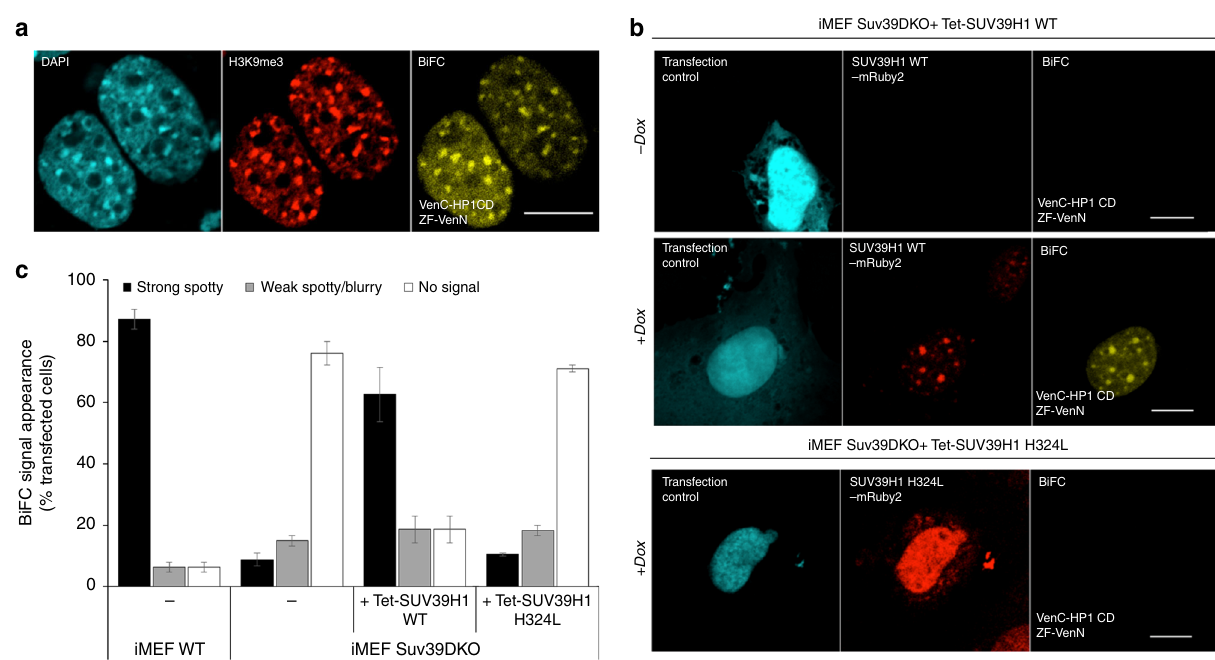
Fig. 6 Readout of changes of H3K9me3 at mouse major satellite repeat sequences using BiAD sensor 4. a Representative fl uorescence microscopy images demonstrating the co-localization of BiFC signal, DAPI staining, and H3K9me3 antibody staining. b Application of the BiAD sensor to detect changes in H3K9me3 levels after dox induced expression of SUV39H1 in Suv39DKO iMEF cells. A BiFC signal could only be observed when the sensor was transfected in cells expressing SUV39H1 ( middle panel ). No BiFC signal was detected in cells expressing the catalytically inactive H324L SUV39H1 mutant ( bottom panel ), c Quanti fi cation of the experiments representatively shown in panels a , b . Error bars represent s.e.m. for two biological replicates (for details cf . Supplementary Tables 4 and 6). Scale bar for all images is 10 µ m. All cells were fi xed 48 h after transfection and the imaging and display settings of the images shown b are